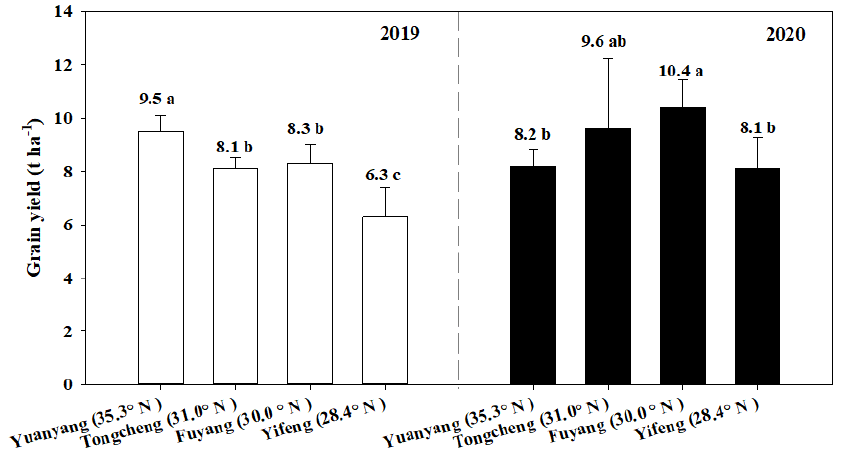
Figure 2. The grain yield in different areas in two years. The value represents the mean yield of six cultivars in each area and year. Vertical bars represent ± standard error of the means of six cultivars ( n = 6). Means followed by different letters are significantly different according to LSD (0.05) for each year.